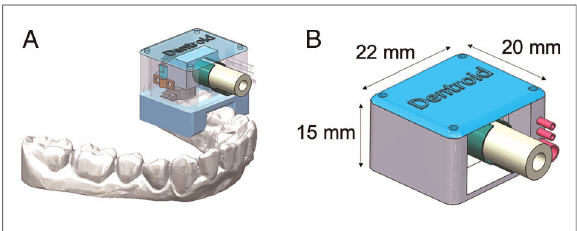
FIGURE 1 ( A ) Conceptual representation of the intraoral device on teeth including a MEMS mirror, a fi ber optic connector for laser delivery, camera, diagnostics system, and external packaging, and ( B ) a schematic view with